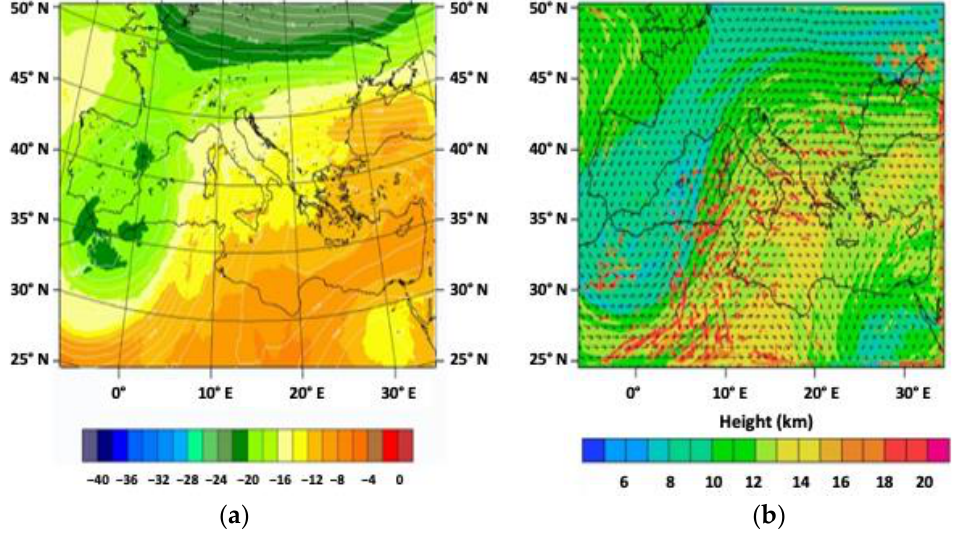
Figure 3. ( a ) Temperature and geopotential height at 500 mb on 16 May 2020, 12:00 UTC, by WRF. ( b ) Geopotential height and wind at tropopause on 16 May 2020, 18:00 UTC, by WRF. Figure 4 shows the variation of UVI, TOC, and AOD during 12–19 May, 2020, as re- trieved by the corresponding instruments. UVI was retrieved from the PSR